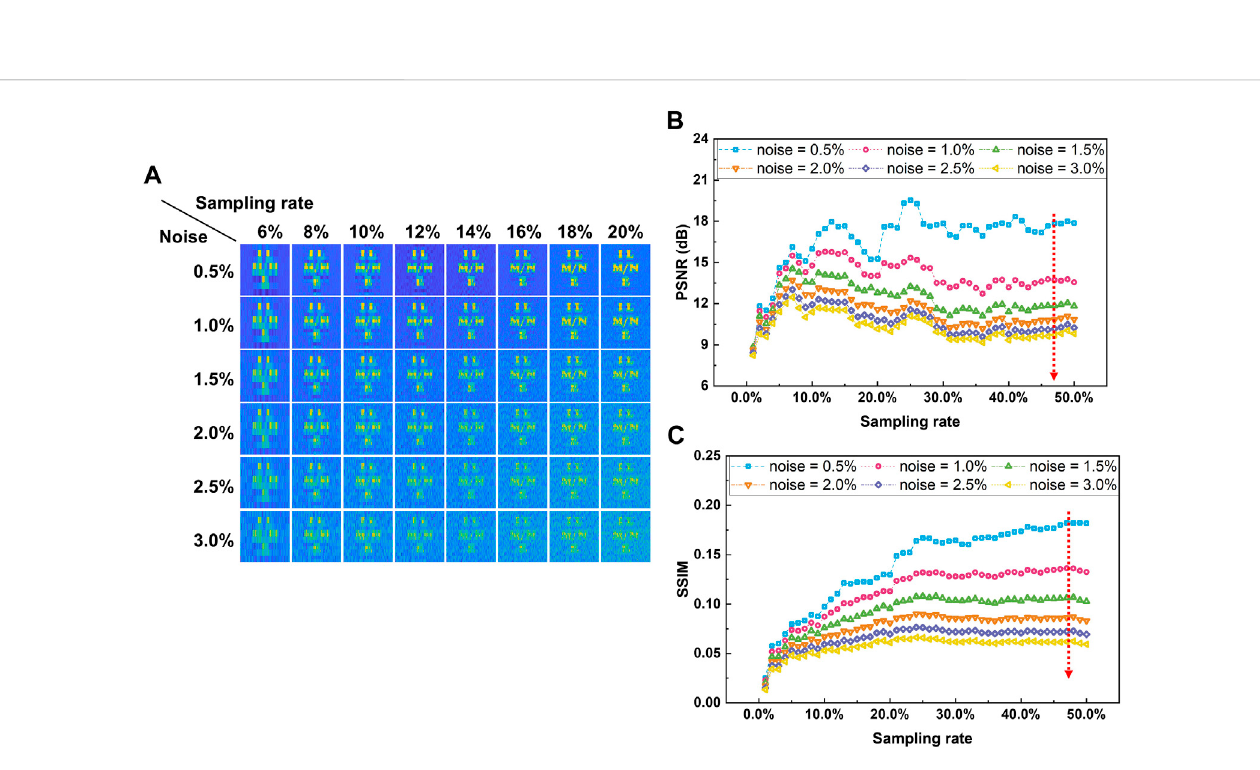
FIGURE 6 (A) Simulated results of laser GI based on Walsh speckle patterns under different random noise. (B) PSNR indicator and (C) SSIM indicator vs . sampling rates under different random noise and sampling